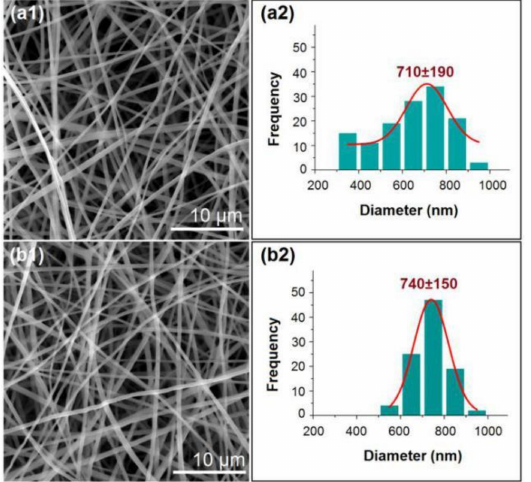
Figure 7. SEM images and size distributions of ( a1 , a2 ) nanofibers from the traditional processes (N1) and ( b1 , b2 ) nanofibers from the new process